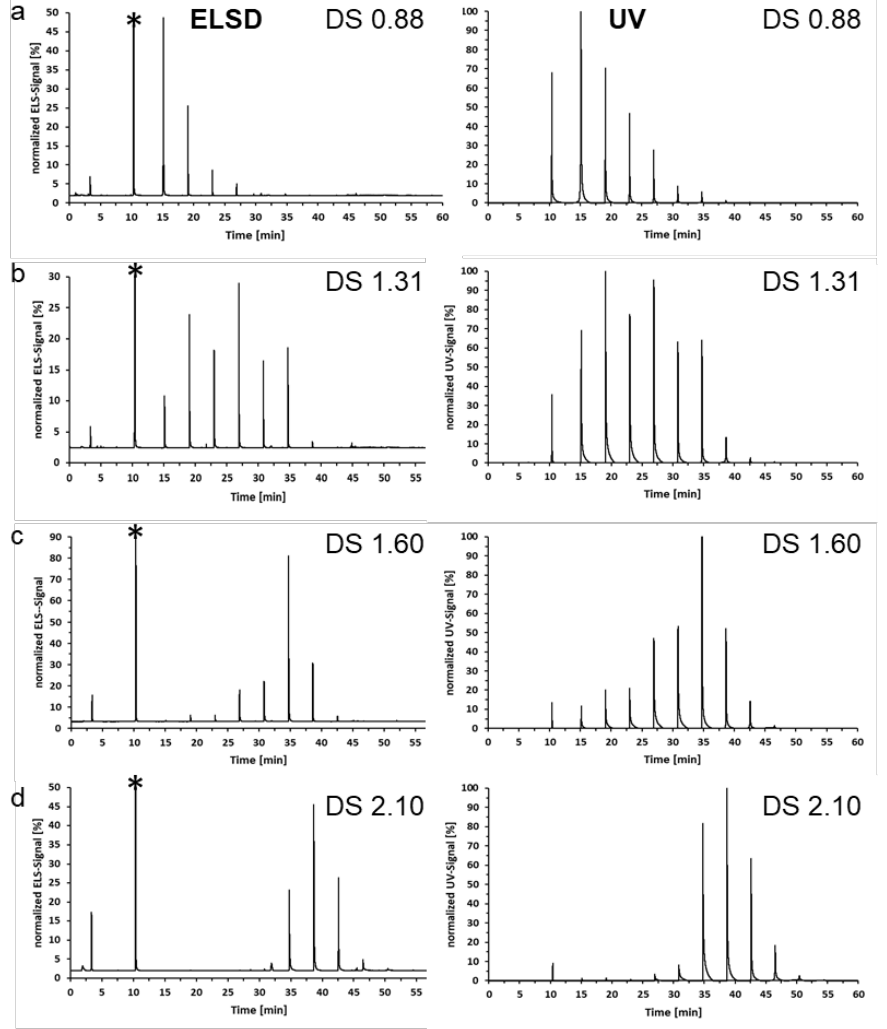
Figure 8. Analytical stepwise gradient HPLC of 4-methoxybenzoates of various MCs (Me-MeOBz, DS Me : ( a ) 0.88, ( b ) 1.31, ( c ) 1.60, ( d ) 2.10) on a silica column with DCM/2-PrOH. Left column: ELSD. Right column: UV (257 nm). Adsorption-desorption technique with stepwise enhancement and